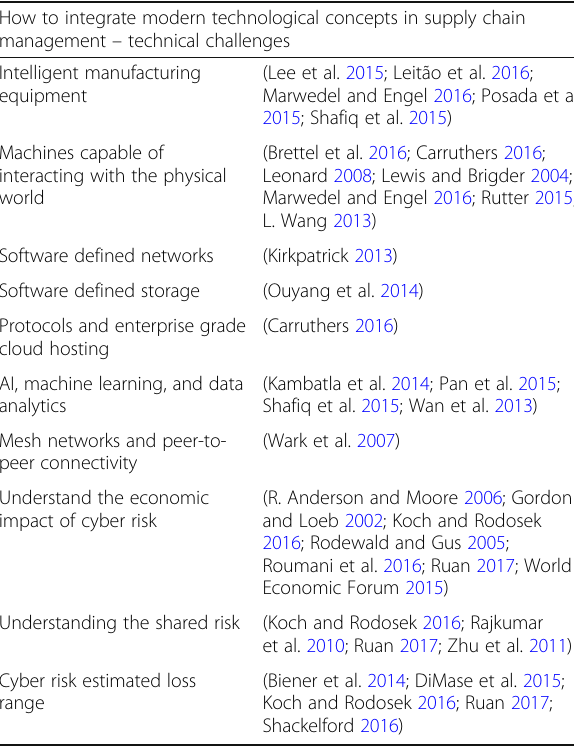
machine learning, and data analytics; and mesh networks Table 1 How to integrate existing supply chain models How to integrate existing supply chain models Consensus on objectives